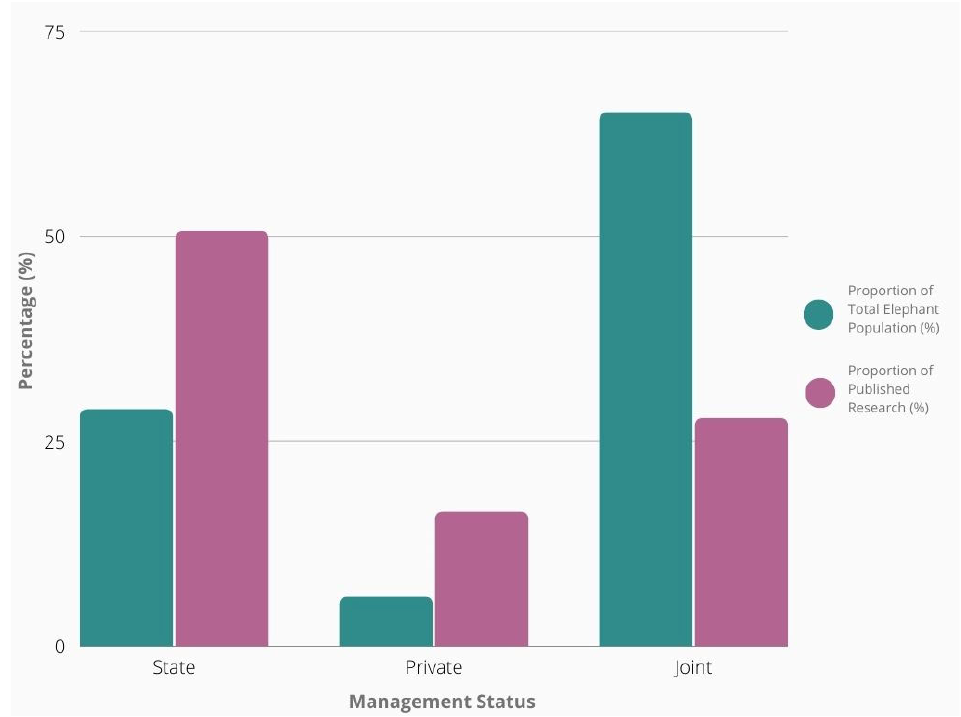
Figure 5. Percentage of research versus proportion of elephant population occurring in publicly managed, privately managed, or joint publicly/privately managed reserves [PAs]. Conservation research is chronically underfunded and highly competitive